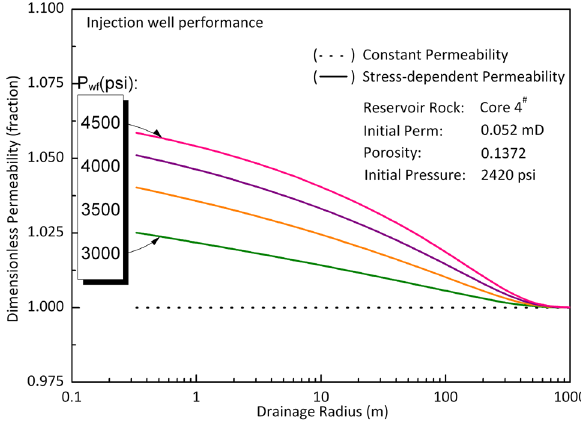
Fig. 9 Permeability distributions on day 300 under different injection